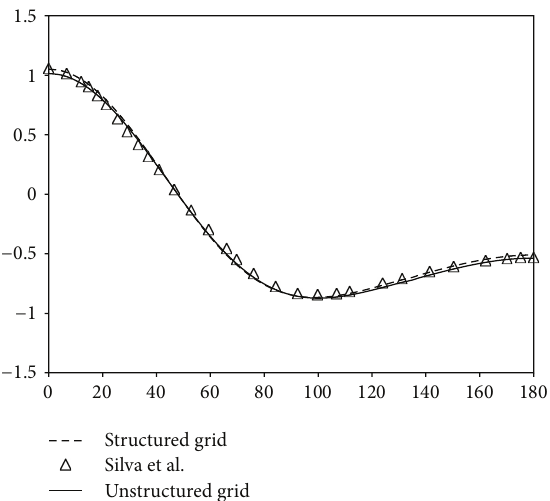
Figure 7: Pressure coefficient distribution, between (𝜃 = 0) and (𝜃 = 180) : Re = 20.